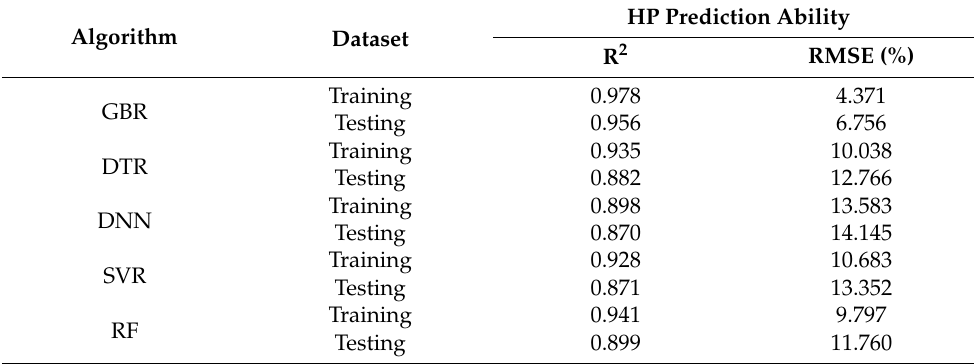
Table 2. R 2 and RMSE values of the ML models.